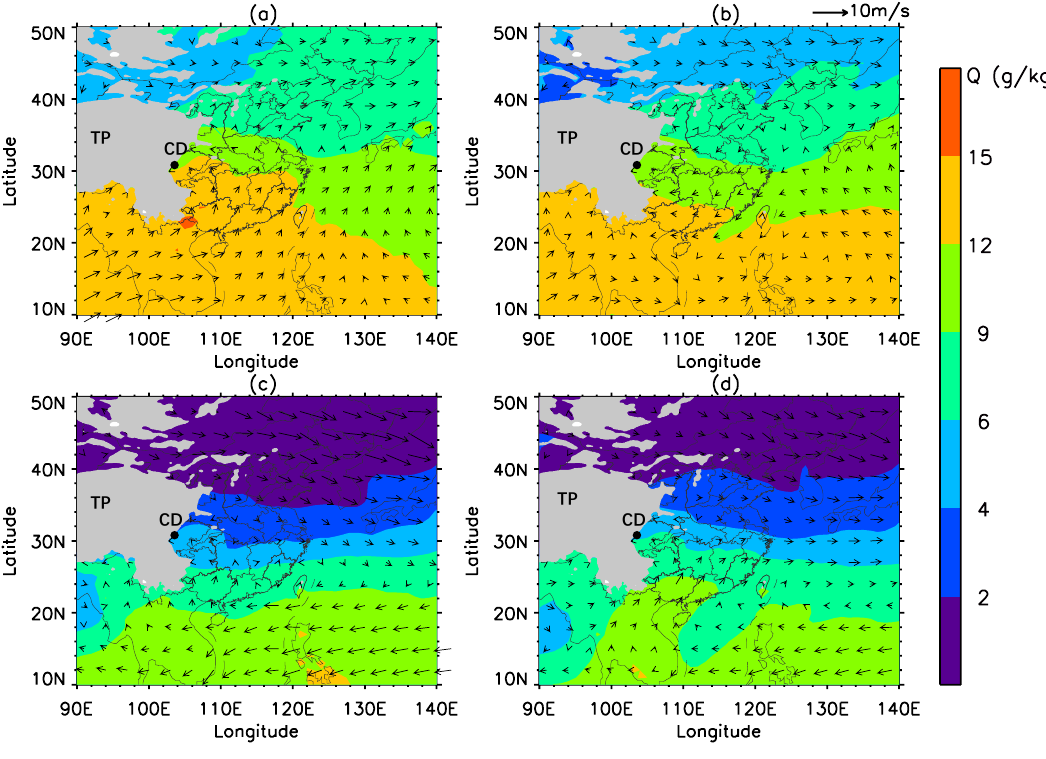
Figure 9. Seasonal averaged 850 hPa horizontal winds and relative humidity during 2018–2020. TP and CD denote the Tibetan Plateau and Chengdu, respectively. ( a – d ) for summer, autumn, winter, and spring, respectively.